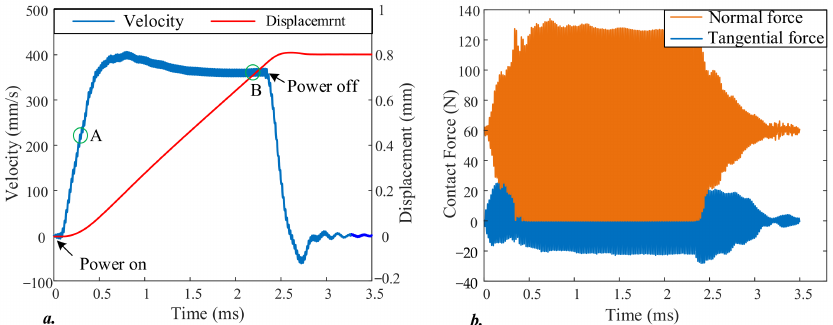
Figure 14. The On/off transients response of the LUSM by simulation: ( a ) the time-domain responses of the velocity and displacement; ( b ) the time-domain responses of the contact force.